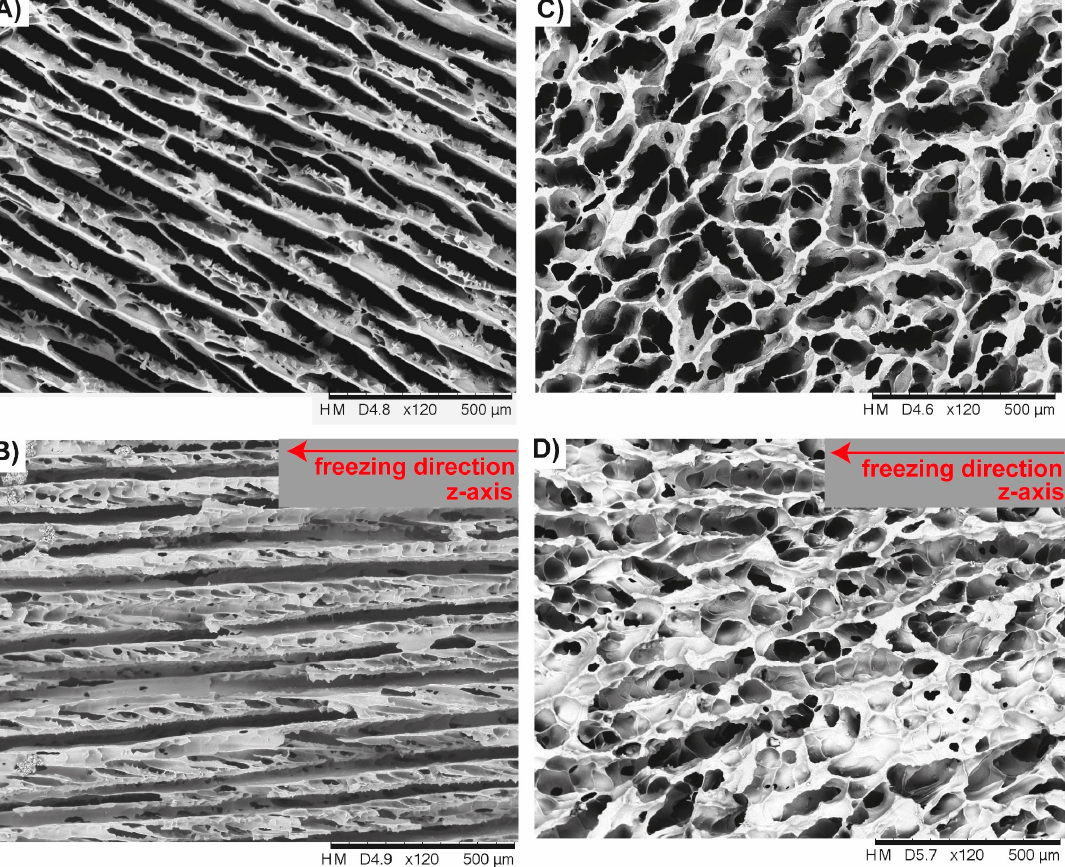
Figure 16. Freeze-casted cellular ceramics inspired by the strut arrangement of the spine’s radiating layer and medulla. Both ceramic types have the solid loading of 14.4 vol.% in common and differentiate in terms of the used gelatin concentration in the suspension. A gelatin concentration of 3.5 vol.% has been used to manufacture the cellular oblate cell structure, ( A ), being highly anisotropic, ( B ), in their pore shape. Polygonal cellular cell shapes, ( C ), can be manufactured with a gelatin concentration of 6.8 vol.% showing rather a foam-like character, ( D ).